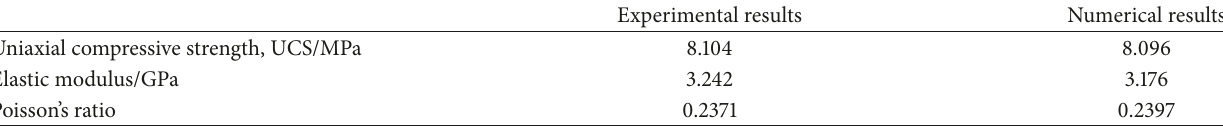
Table 4: Comparison between experimental and numerical results for the macromechanical parameters of intact specimen.